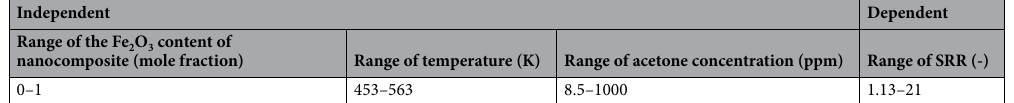
Table 1. Acetone detecting ability of the In 2 O 3 /Fe 2 O 3 nanocomposite sensors 4,8,9,21 .